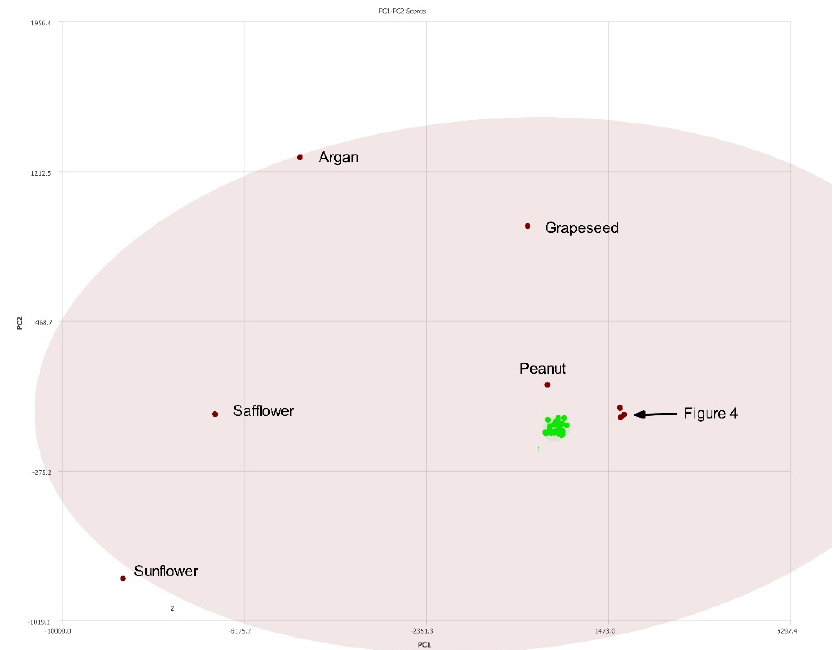
Figure 3. PC1–PC2 plot of 400 MHz 1 H NMR spectra of seed oils (labeled) versus olive oils (green). Ellipses represent the 95% confidence interval. The congested region is expanded in Figure 4.